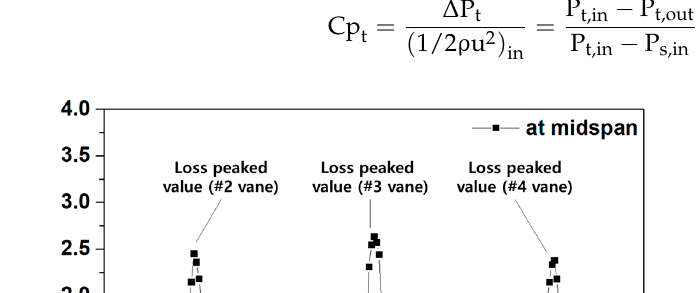
Figure 5. Measurement region of the total pressure loss (rear view). 2.5. Measurement Uncertainty Estimation As defined in Equation (3), the total pressure loss coefficient is a function of pressure terms. The measurement uncertainty was estimated by calculating the propagation of un- certainties. The method used in the study was well-documented by Kline [17]. For the